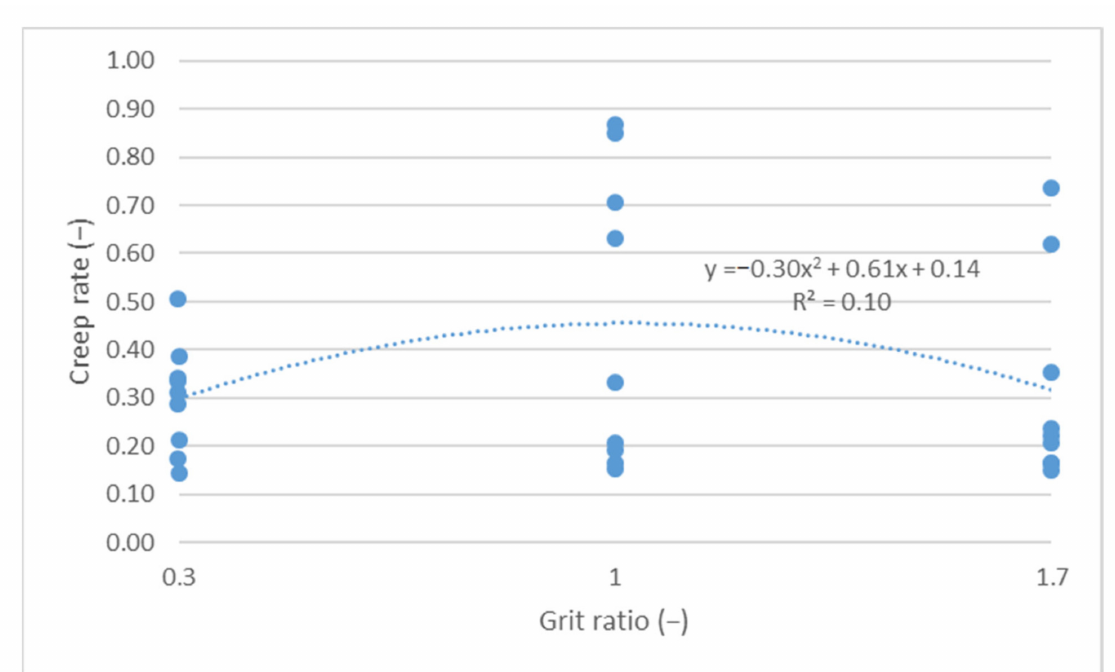
Figure 8. Creep rate vs. grit ratio.